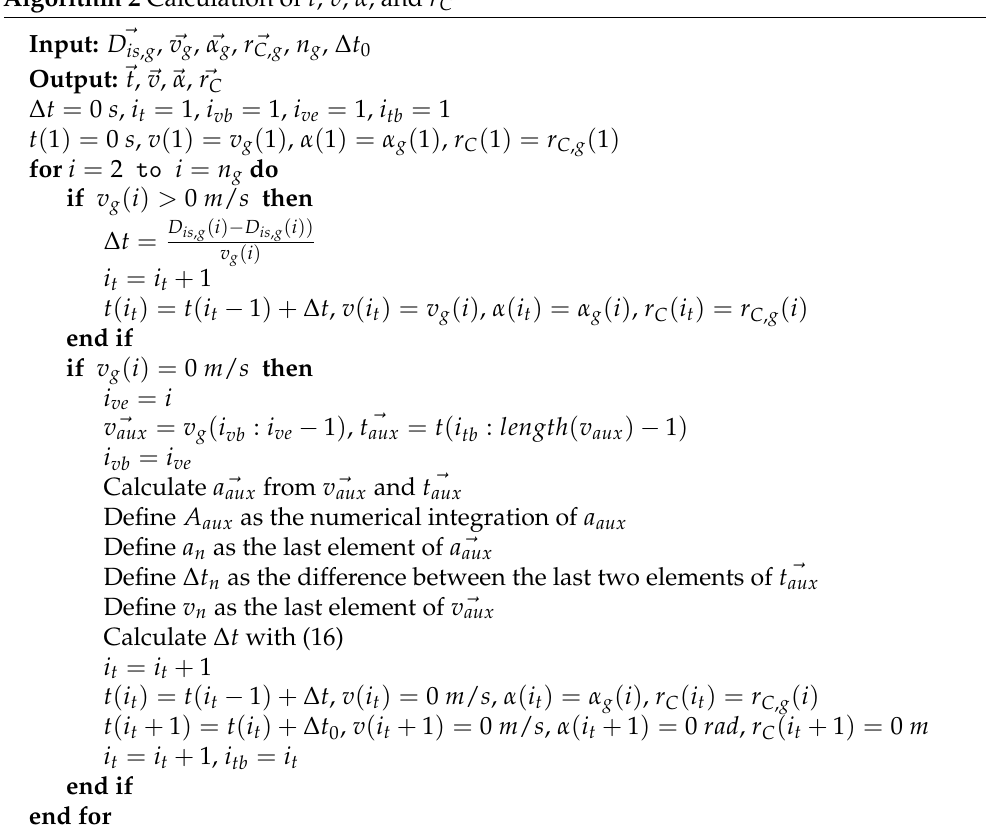
Algorithm 2 Calculation of (cid:126) t , (cid:126) v , (cid:126) α , and (cid:126) r